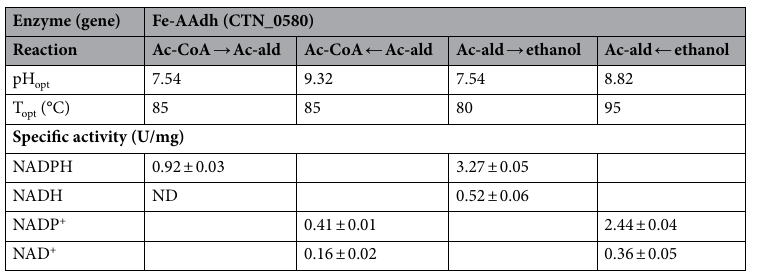
Table 2. Optimal reaction conditions and coenzyme specificity for enzyme Fe-AAdh. Ac-CoA acetyle-CoA, Ac-ald acetaldehyde, ND activity not detectable.